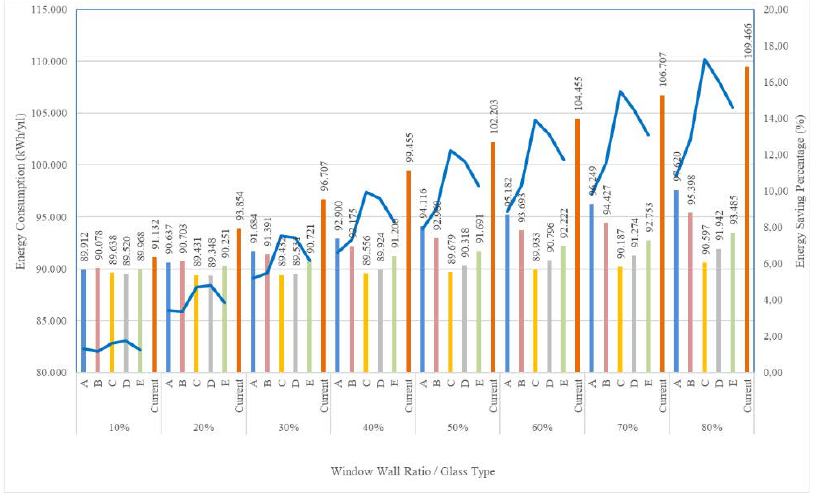
Figure 10 Energy saving rates, calculated energy consumptions and reference energy consumptions for